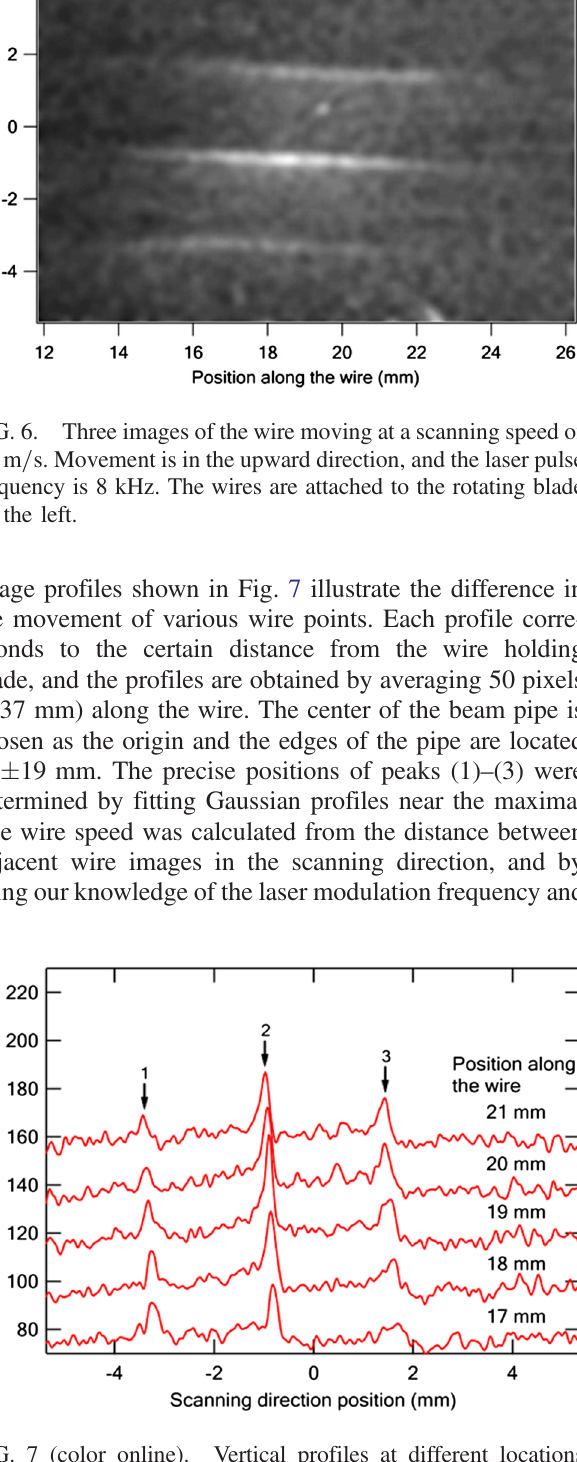
FIG. 7 (color online). Vertical profiles at different locations along the wire obtained by taking vertical slices at several horizontal positions of the image in Fig. 6 (horizontal axis corresponds to the vertical axis in Fig. 6). Peaks (1), (2), and (3) are used for determining the distance between adjacent wire images and for subsequently calculating the wire's